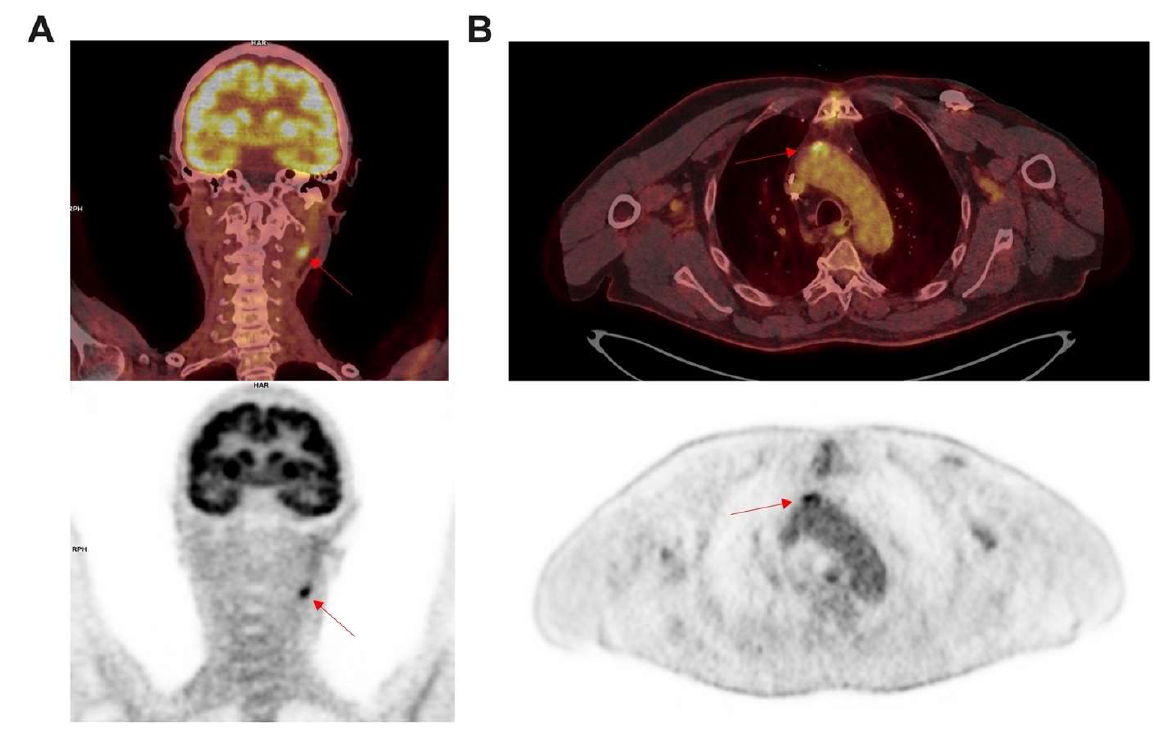
Figure 2. Incidental findings from atherosclerosis in [ 18 F]FDG PET/CT imaging. Left panel ( A ) show coronal images performed for a lung cancer disease in 75 years old women. Intense focal uptake was found (( A ) red arrow) corresponding to an inflammatory atherosclerosis process of left internal carotid. Right panel ( B ) show axial images performed to characterize lung nods in 76 years old patient also followed for a diabetes, tabagism and coronary bypass. Intense focal uptake was found in the ascending aorta (( B ) red arrow) corresponding to an inflammatory process in an atherosclerosis plaque with mineralization.